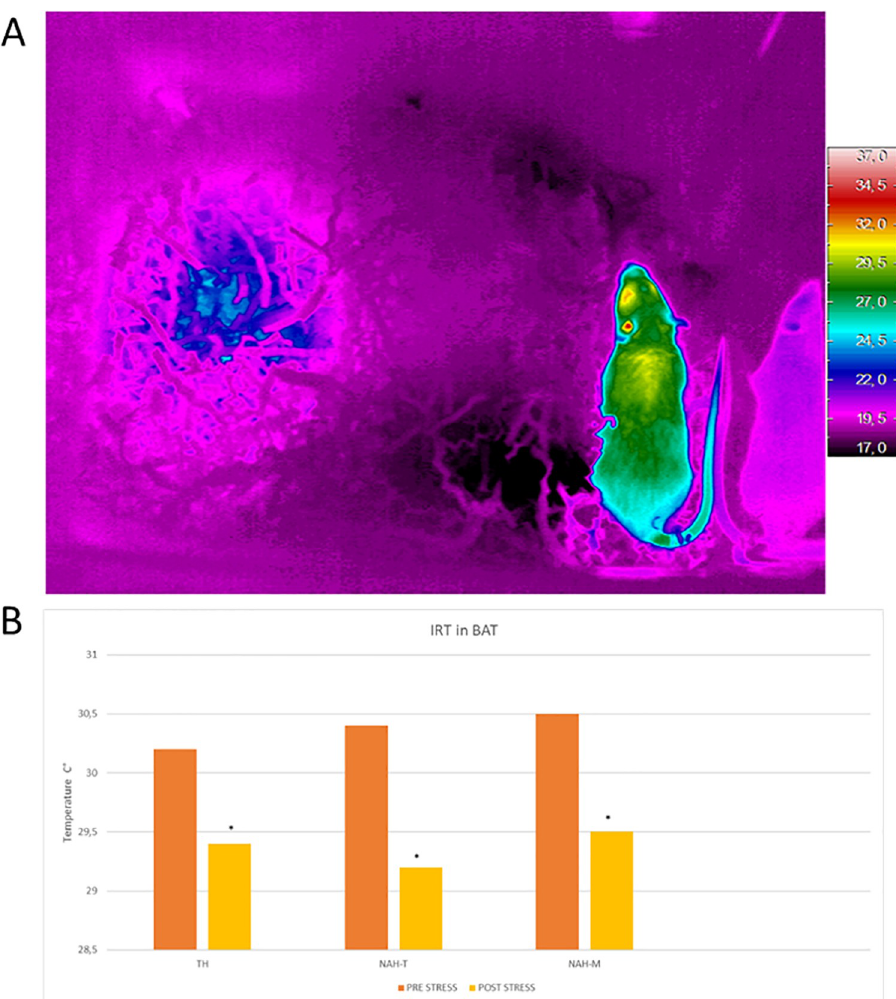
Fig 3. IRT image and measurements. A-Example of IRT image of a mouse: the part in yellow on the dorsal region is the BAT area. B-IRT measurements: after R&L stress test, the temperatures recorded in the BAT area in all experimental groups were lower than those recorded at baseline, suggesting that this stress stimuli might affect BAT homeostasis, with possible consequences on metabolism ( � p < 0,03 vs baseline).